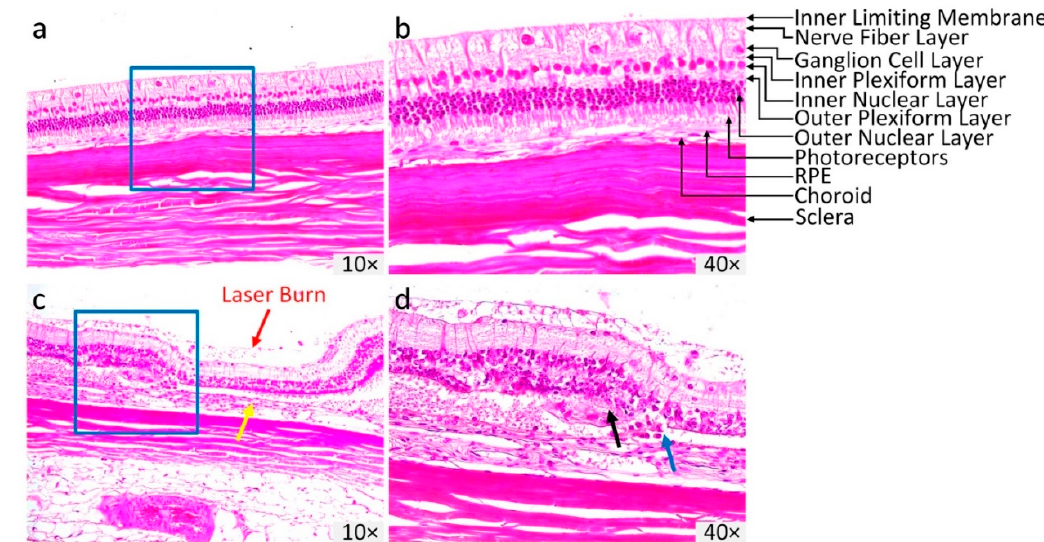
Figure 6. Histopathological analysis of CVO. ( a , b ) Hematoxylin and eosin (H&E) images acquired from control eyes without laser treatment showing the normal retinal morphology and different layers of the retina. ( c , d ) H&E images of CVO obtained at day 28 post laser illumination. At the laser injury site, the retinal layer demonstrated significant change in retinal morphology, with the thickness reduced from the control group. Red arrows illustrate the position of laser injury site. Magnification: 10× and 40×.